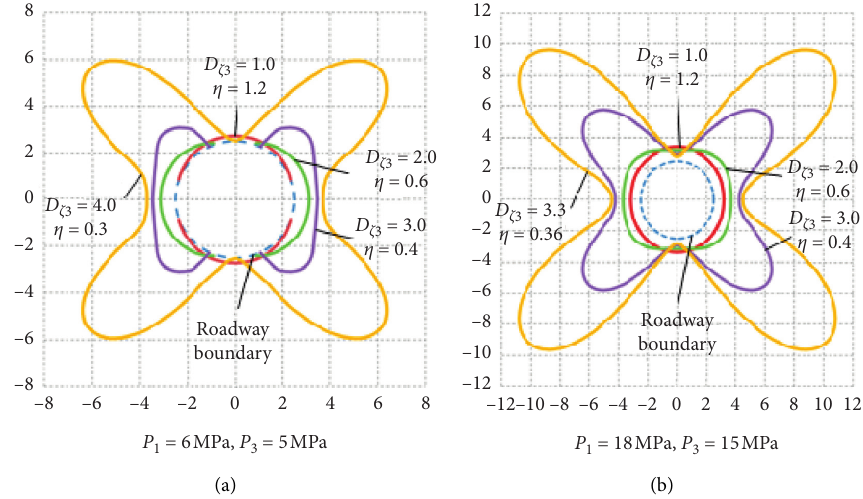
Figure 2: Morphology distribution of the roadway plastic zone influenced by the minimum principal